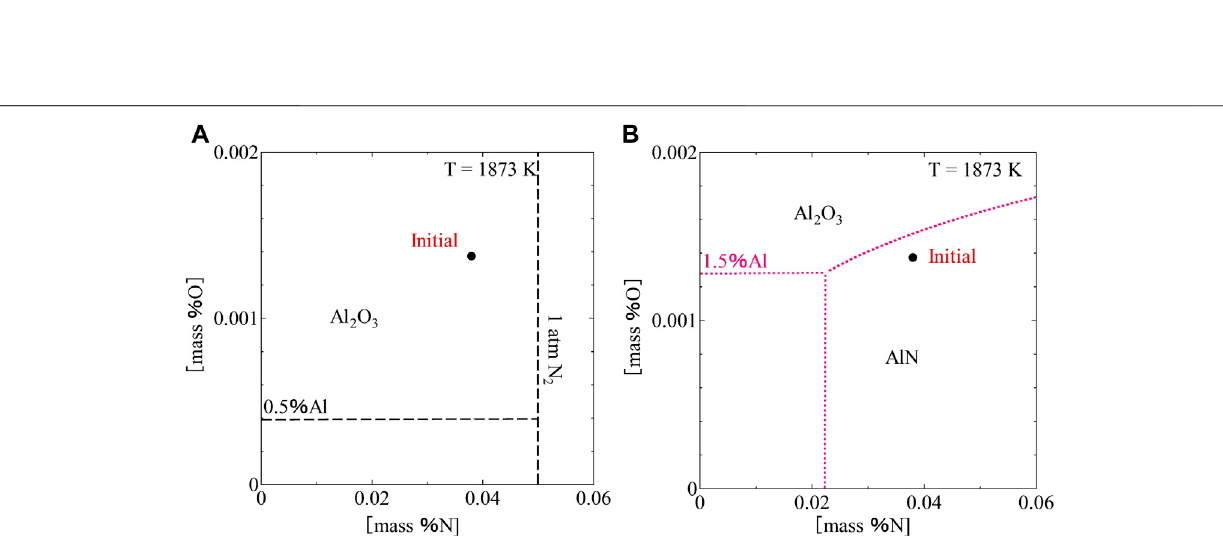
Frontiers in Materials |